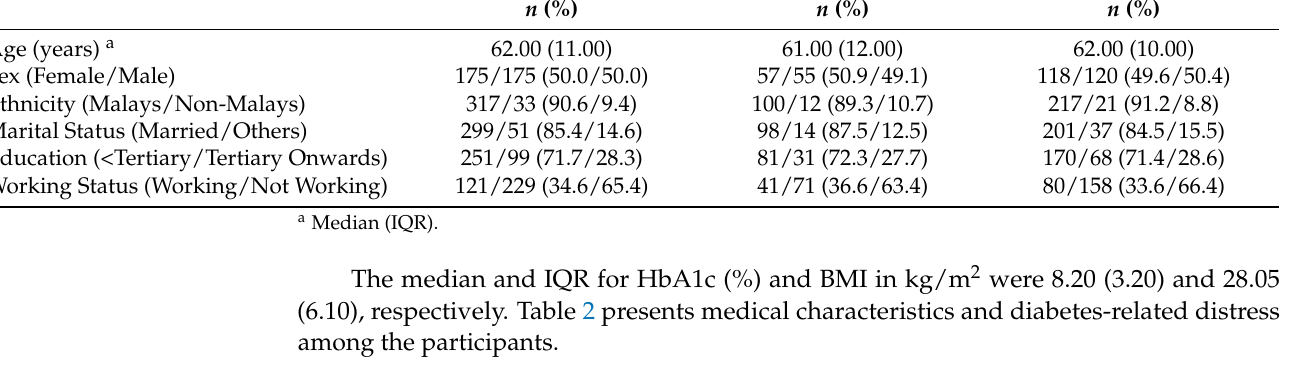
Table 2. Medical characteristics and diabetes-related distress among participants ( n =